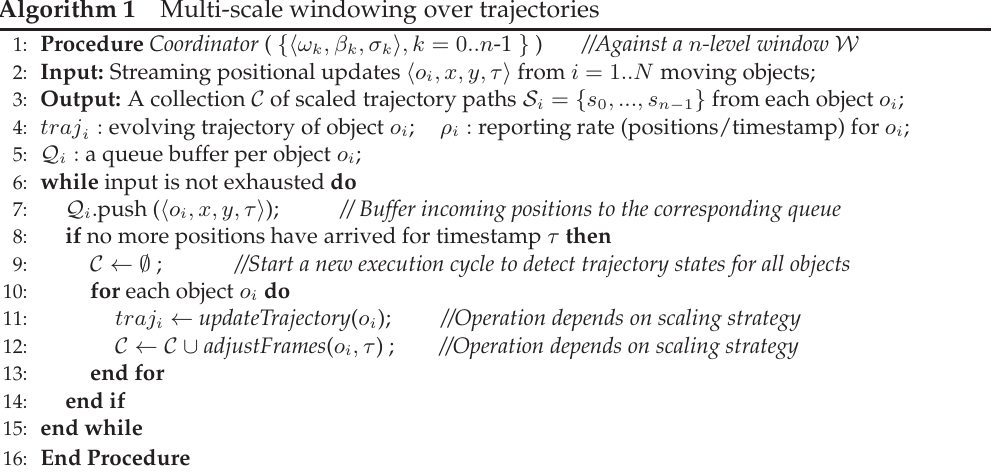
Figure 4: A window frame W k specifying (cid:3) ω k = 20 , β k = 4 , σ k = 0 . 5 (cid:4) over a trajectory. Algorithm 1 Multi-scale windowing over